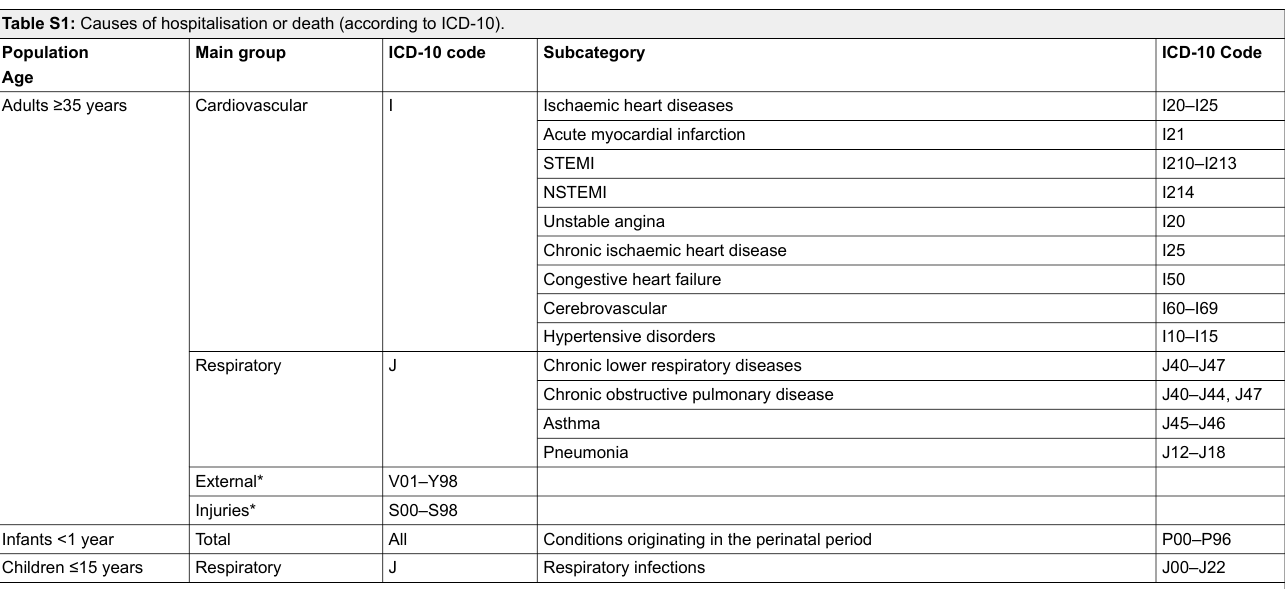
Table S1: Causes of hospitalisation or death (according to ICD-10).